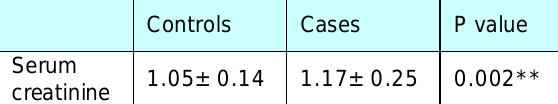
Table 2 : Mean levels of serum creatinine